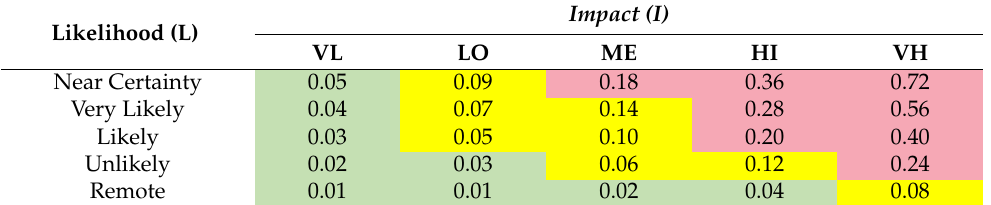
Table 8. Risk exposure matrix (1)